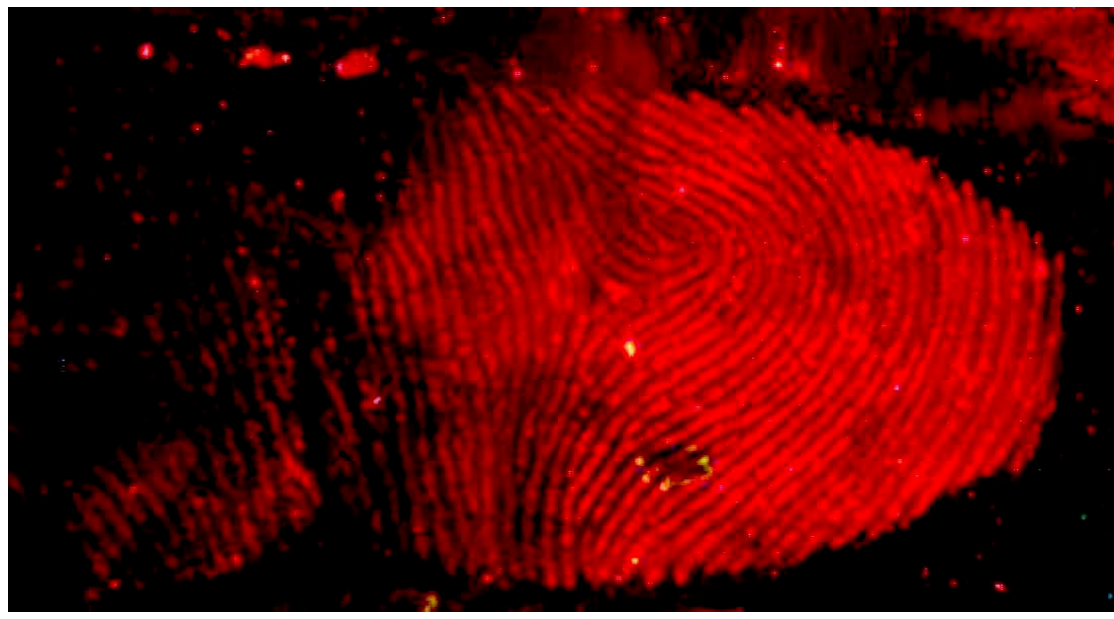
FIGURE 2. One-month-old fingerprint on aluminum foil developed by SYPRO fi